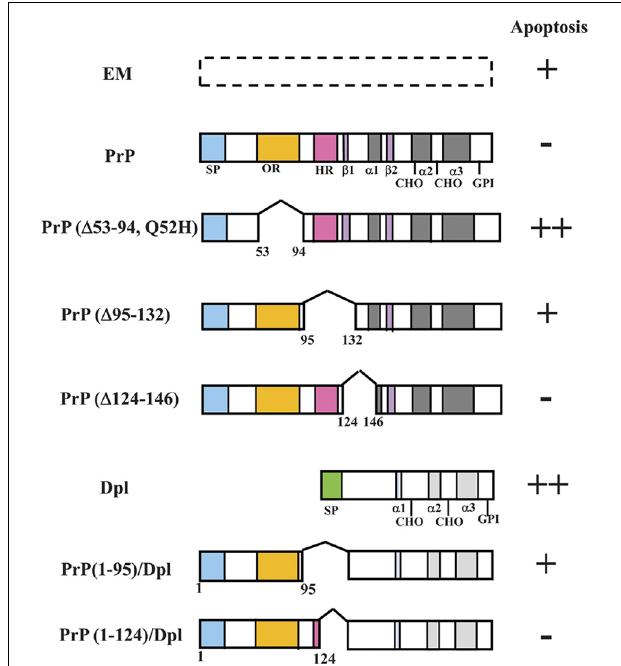
FIGURE 3 | Schematic representations of PrP deletion mutants or PrP-Dpl fusion proteins and Prnp − / − cells (HpL3-4) expressing these mutants that undergo apoptosis under serum deprivation. Schematic representations of deletion mutants of mouse PrP and PrP-Dpl fusion protein are shown. Mutants of mouse PrP [PrP: wild-type PrP; (cid:2) #1, PrP( (cid:2) 53-94, Q52H); (cid:2) #2, PrP( (cid:2) 95-132); (cid:2) #3, PrP( (cid:2) 124-146)] were prepared using restriction digestion/ligation. Schematic locations of the deletions as compared with the wild-type protein are shown by a space within the bar next to the indicated protein. Dpl lacks sequences homologous to the octapeptide repeat (OR) and hydrophobic regions (HR) of PrP. ORDpl [PrP(1-95)-Dpl] is Dpl fused with amino acid residues 1-95 of PrP containing the OR. ORHRDpl [PrP(1-124)-Dpl] is Dpl fused with amino acid residues 1-124 of PrP containing the OR and N-terminal half of HR. The numbers refer to the amino acid residues in the mouse PrP sequence or Dpl sequence. The Asn-linked glycosylation sites (CHO), signal peptide sequence (SP), octapeptide repeat region (OR) and hydrophobic region